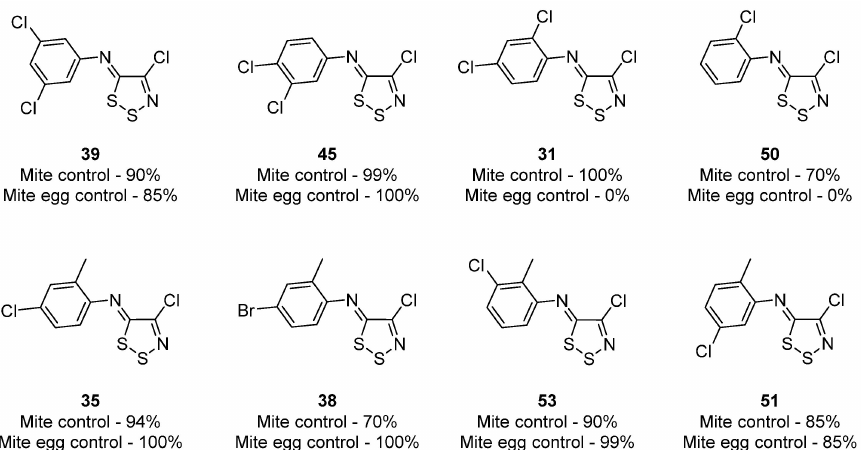
Figure 6. Mite ( Tetranychus urticae ) control activities of early 1,2,3-dithiazole derivatives at 40 ppm.